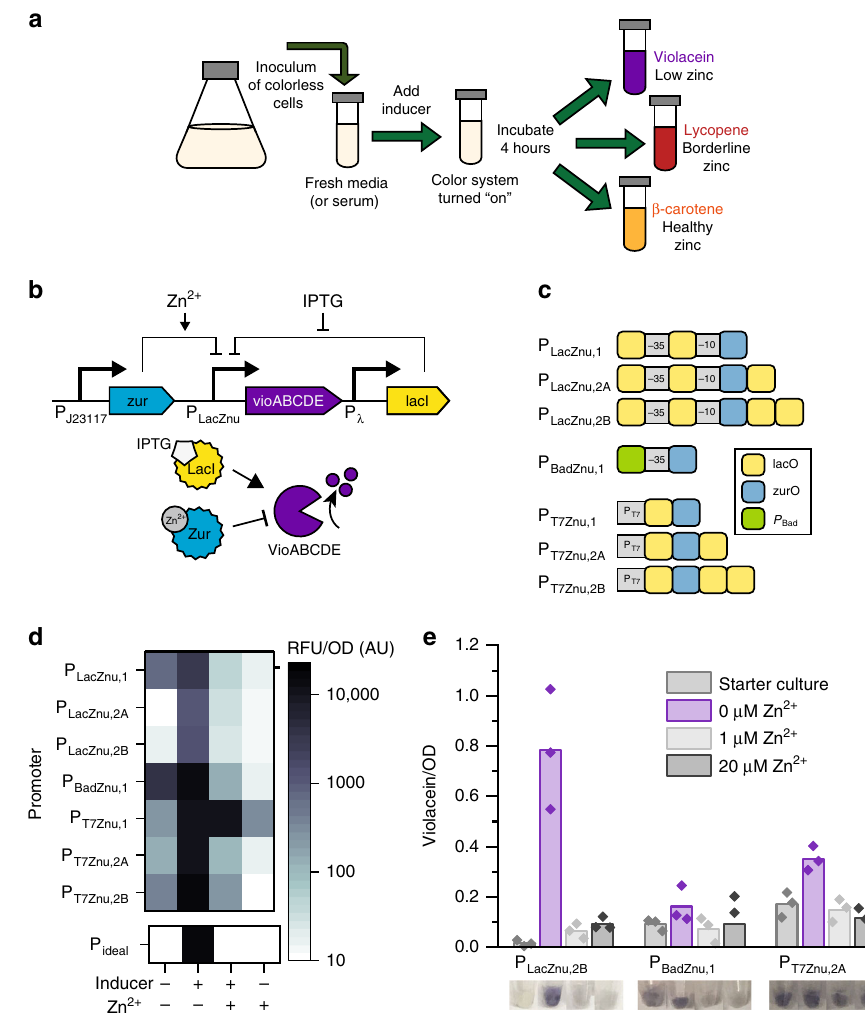
Fig. 1 Dual-input promoters decouple cell growth and pigment production. a Design of a dual-input system that decouples pigment production from cell growth. Colorless cells are added to fresh medium or to a serum sample at a density high enough that cells are visible, and a small-molecule inducer